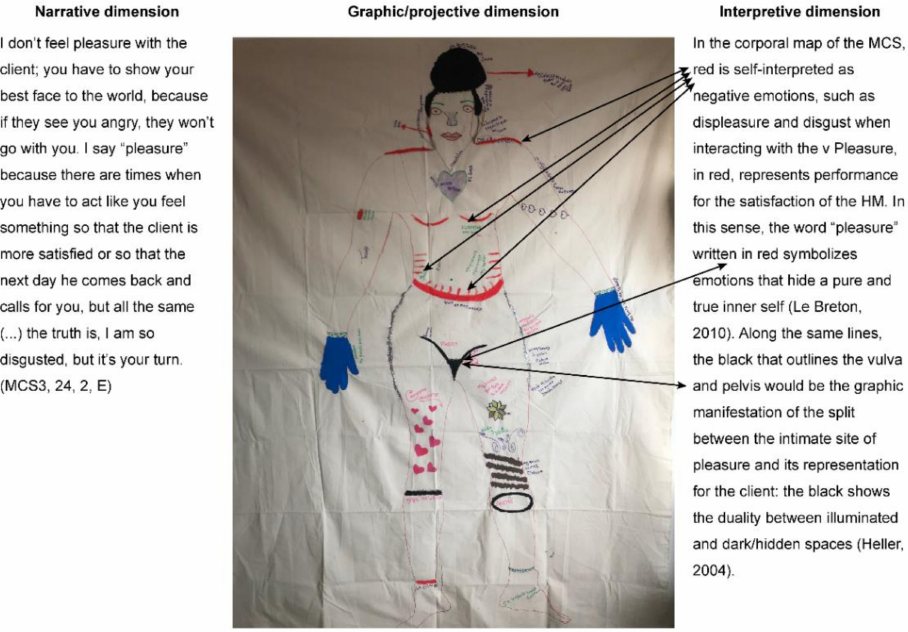
Figure 4. Example of a participative intertextual analysis and its three dimensions. Source: Self-created. Own elaboration. Dimension narrative = Narrative dimension. I don’t feel pleasure with the client; you have to show your best face to the world, because if they see you angry, they won’t go with you. I say “pleasure” because there are times when you have to act like you feel something so that the client is more satisfied or so that the next day he comes back and calls for you, but all the same ( ... ) the truth is, I am so disgusted, but it’s your turn. (Women sex worker, 24, 2, E). Dimension Grafico/proyectiva = Graphic/projective dimension. Dimension interpretative = Interpretive